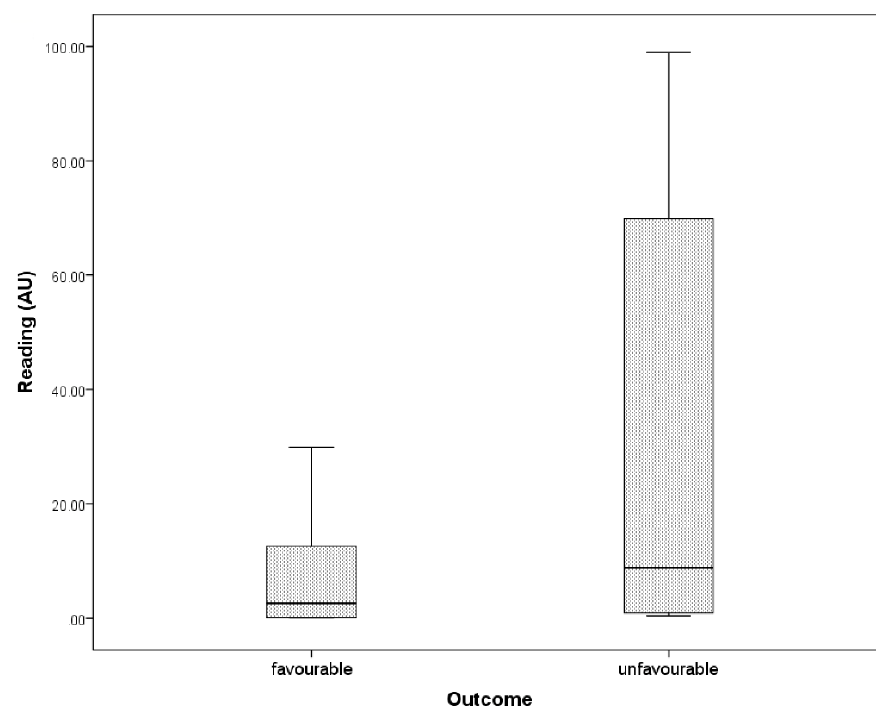
Figure 2. Levels of fluorescence reading (AU) reflects patients’ ( n = 65) response to endodontic treatment according to “loose” success criteria. The probability of 12-month success was 4.5 times (Odds ratio (OR) = 0.028; 95% confidence interval (CI): 0.003, 0.291, p = 0.001) higher when the fluorescence reading was lower than 67 (%) with success rates of 90% and 20%, respectively, for teeth with readings below and above this threshold. Table 2. Relationship between the outcome of root canal treatments according to preoperative variables as determined by PR and